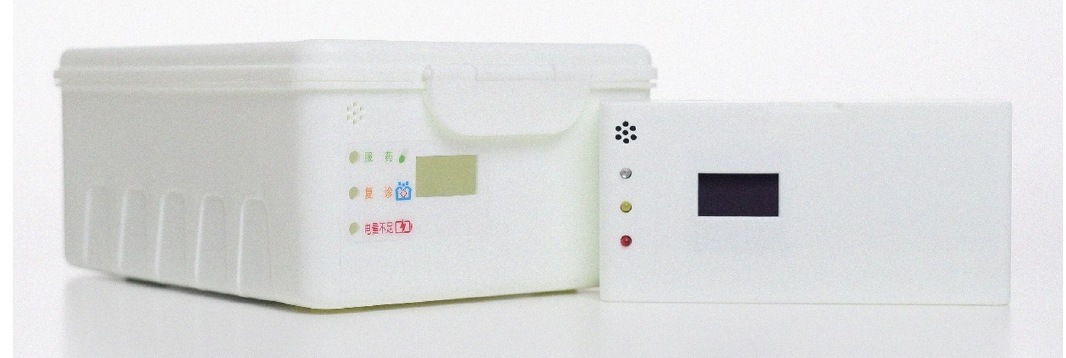
Fig 1. Picture of the electronic medication monitor device used for notified people with TB in the 30 selected counties of China. � � size: 16cm × 12.5cm × 7.3cm.